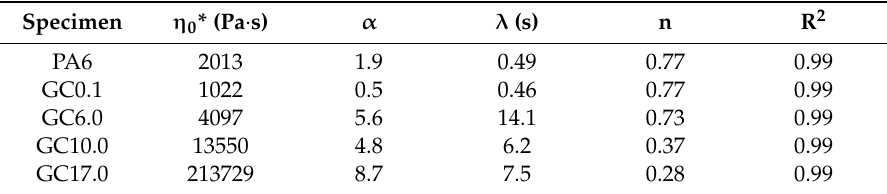
Table 1. Carreau–Yasuda model parameters of PA6 and GC.